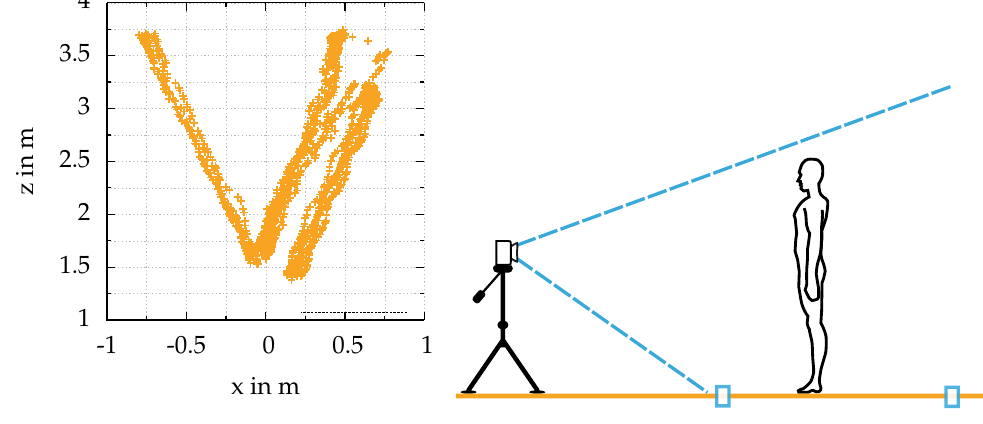
Figure 7. Poses of people walking towards the camera ( a ): The complete datasets consist of several independent experiments. Therefore, the poses of the people walking differ, depending on the orientation of the camera. The people stand at the first marker ( b ). While walking towards the second marker close to the camera, every frame from the sensor is saved for offline processing. The recording is stopped when the second marker is